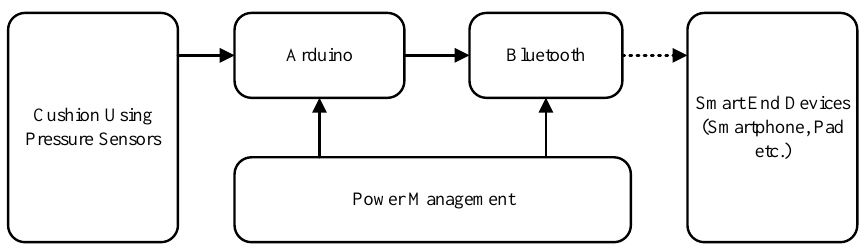
Figure 2. Hardware design of the smart cushion.